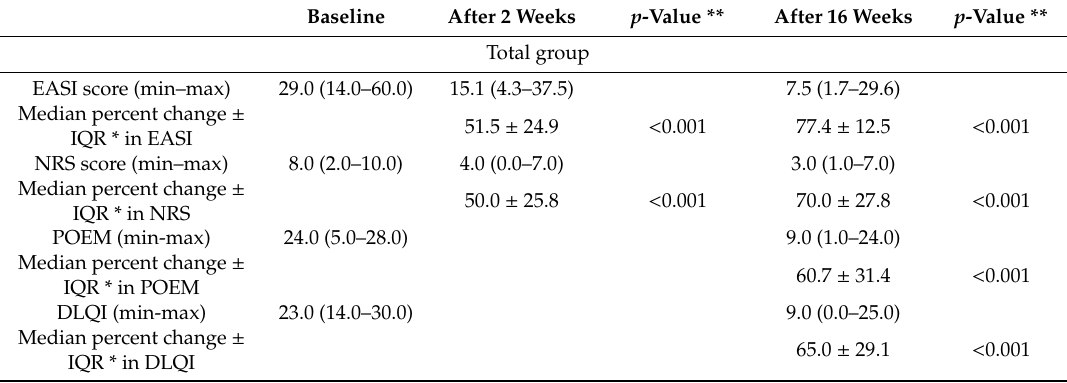
Table 3. Percent change in e ffi cacy tools after two weeks and 16 weeks. All scores showed